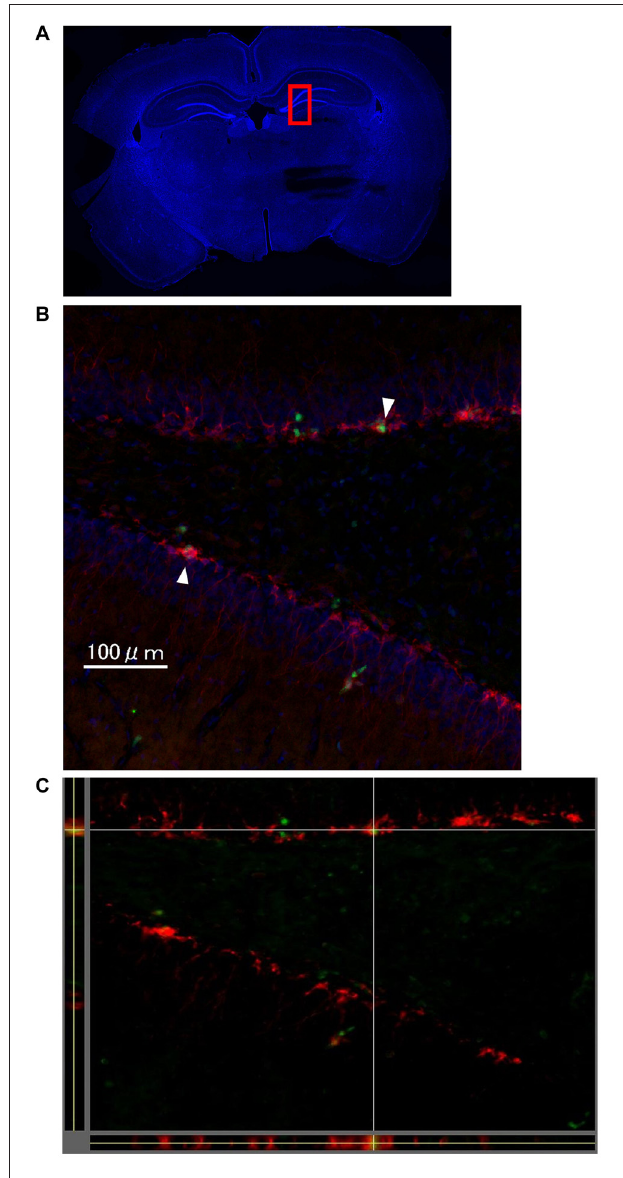
FIGURE 4 | The images show representative immunohistochemical staining in dentate gyrus (DG; Bregma − 4.0 mm) on the stimulated side in the LTP(+) group. There were some Ki67 (green)/DCX (red) double-positive cells in the DG (arrowhead; A : very low magnification with DAPI staining, B : high magnification of rectangle area (red) of A,C : orthogonal view of B , green: Ki67, red: DCX, blue: DAPI).